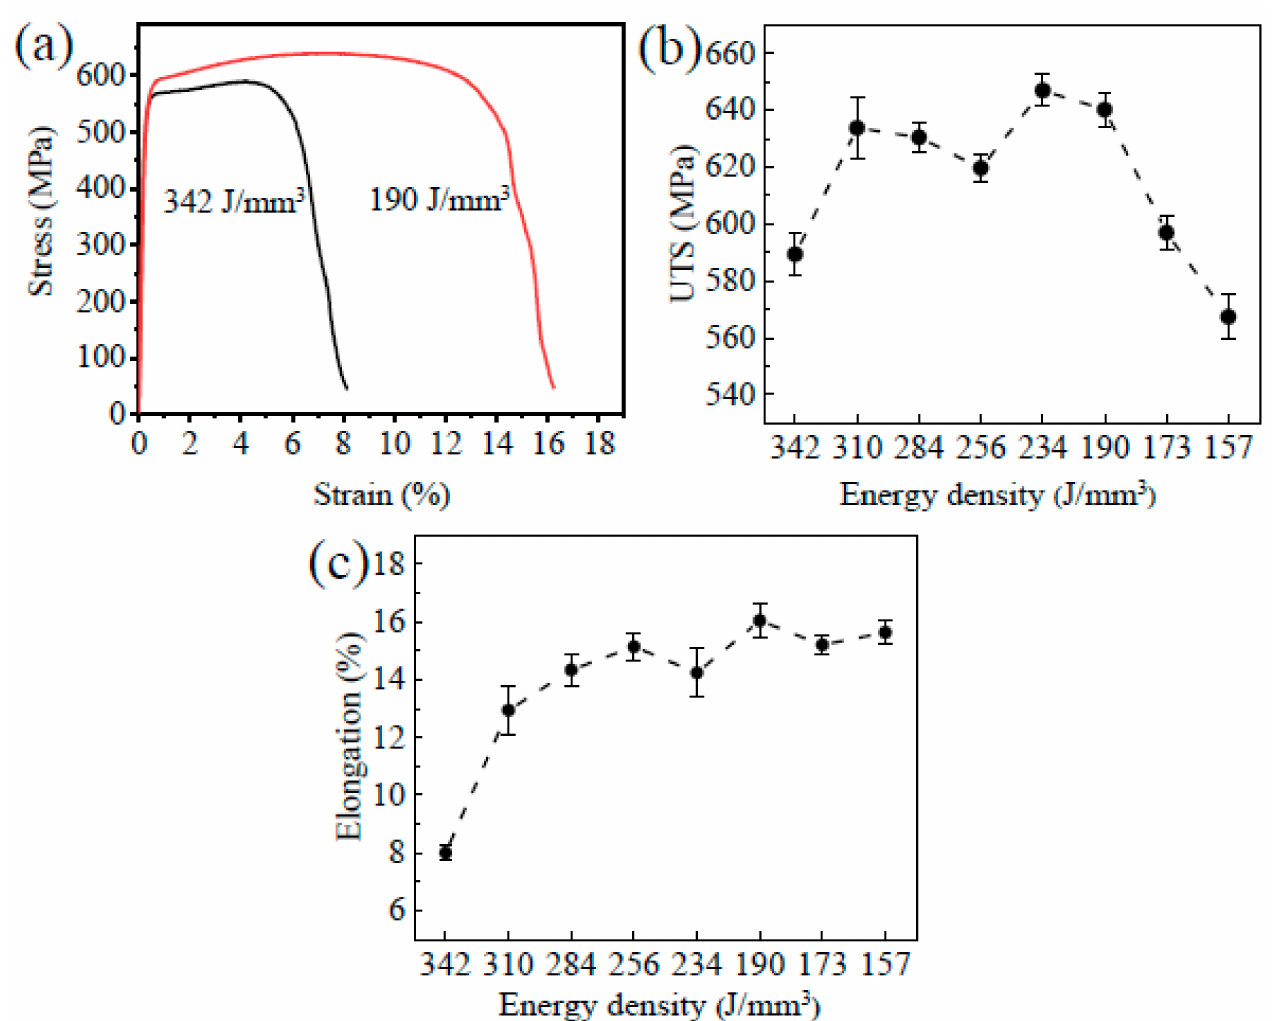
Figure 6. ( a ) Tensile stress–strain curves, ( b ) Ultimate tensile strength and ( c ) Elongation of SLMed Ta prepared at different energy